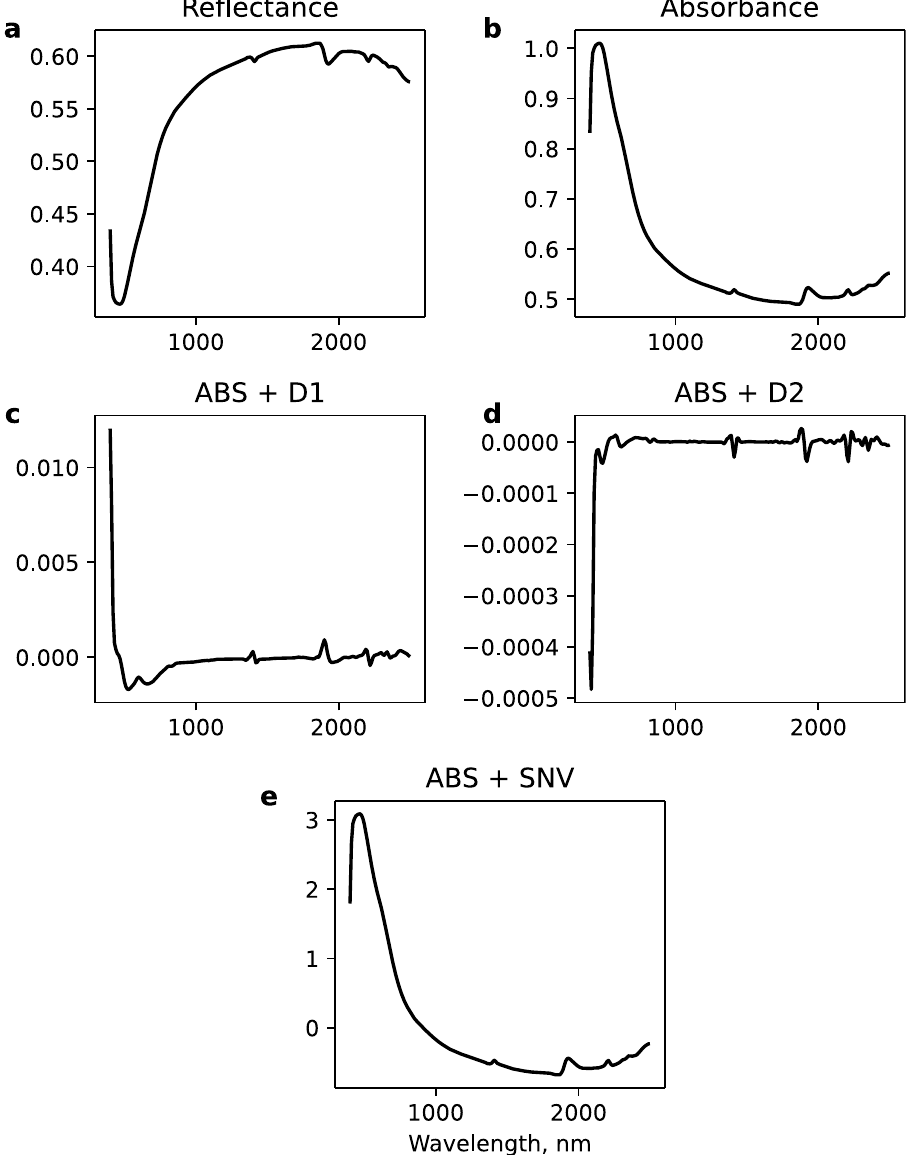
Figure 7. Input channels derived from different preprocessing methods. ( a ) Reflectance. ( b ) Absorbance. ( c ) Absorbance + first derivative. ( d ) Absorbance + second derivative ( e ) Absorbance + standard normal